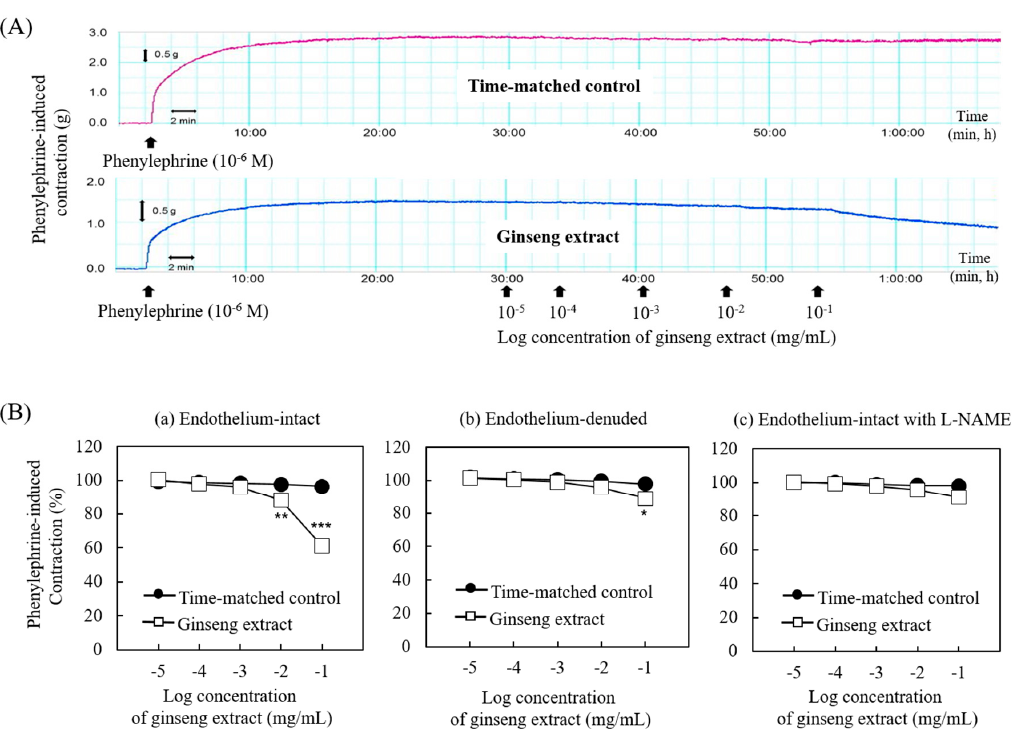
Figure 4. Traces showing the dose–response curves induced by cumulative addition of the ginseng extract in endothelium-intact aorta precontracted with phenylephrine ( A ) and the effect of ginseng extract on phenylephrine-induced contraction of the isolated endothelium-intact (a; N = 9) and -denuded rat aorta (b; N = 5 ) and isolated endothelium-intact rat aorta pretreated with N W -nitro arginine methyl ester (L-NAME) (c; N = 8) ( B ). Data are shown as mean ± SEM and expressed as percentage of maximal contraction induced by phenylephrine. N indicates the number of isolated rat aorta. * P < 0.05, ** P < 0.01, and *** P < 0.001 vs. time-matched control.